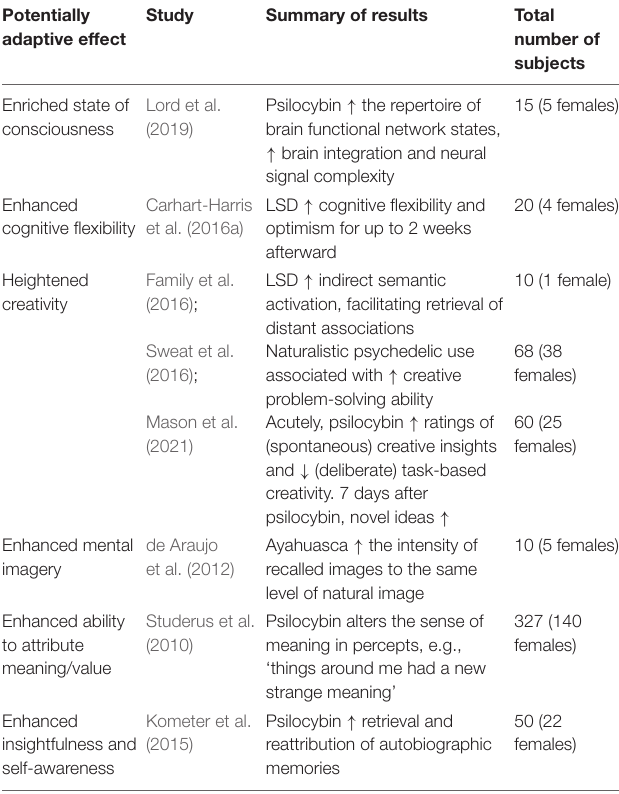
TABLE 3 | Evidence for enhanced cognitive capacities during and after psychedelic